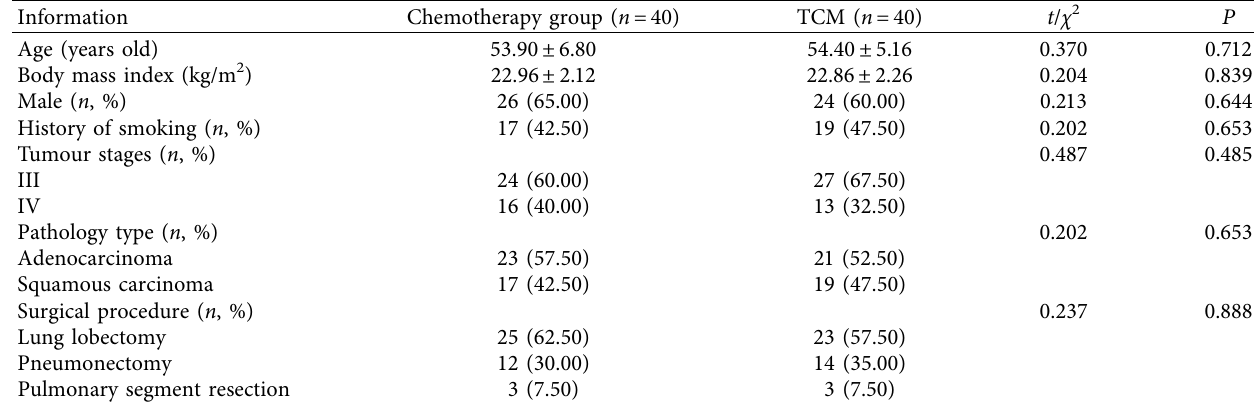
Table 1: Comparison of clinical features between the two